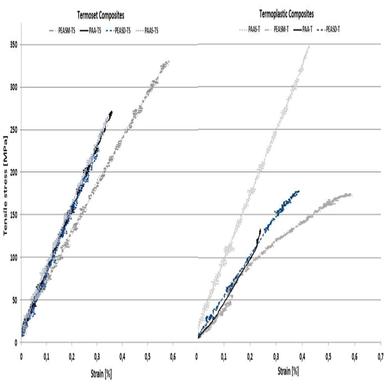
The average tensile stress-strain curves of the advanced composites.